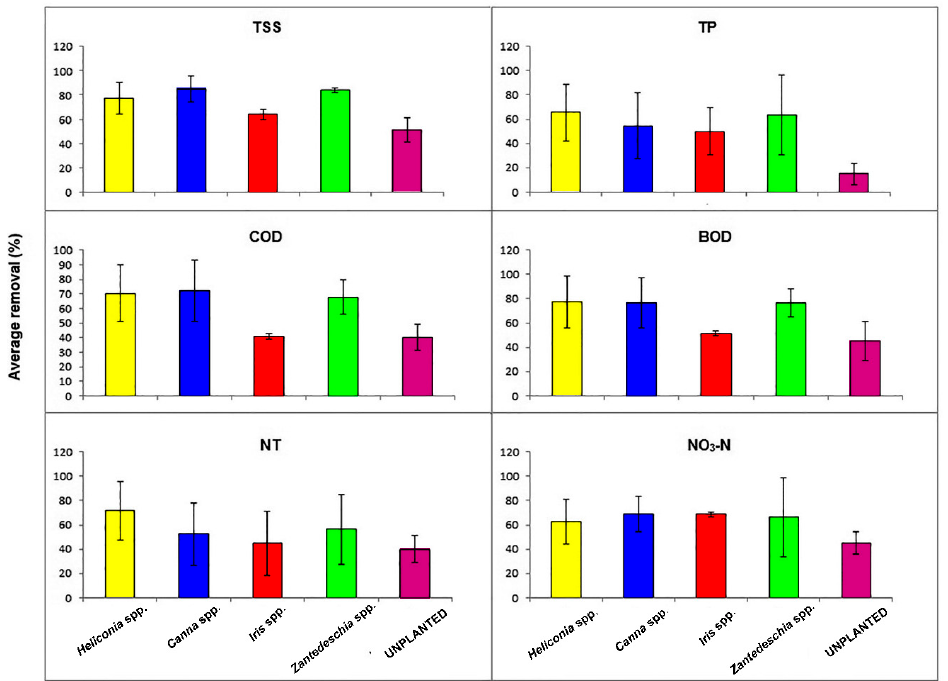
Figure 2. Comparing the average removal efficiencies of contaminants using ornamental plants and systems unplanted in various CW systems in the globe.